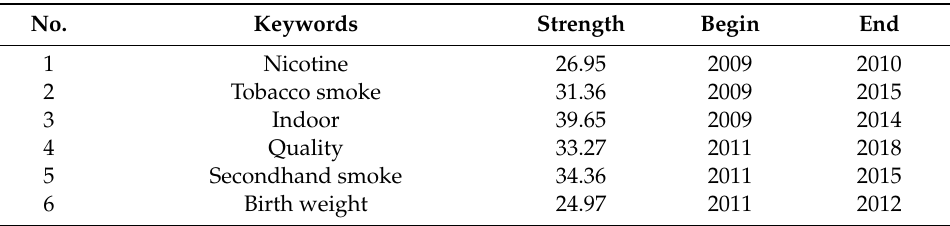
Table 4. The analysis of keywords from 1999 to